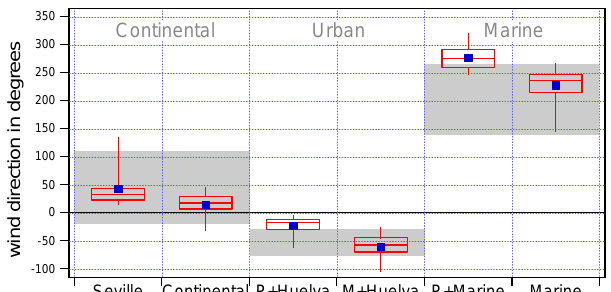
Fig. 3. Comparison of wind directions associated with the classified air mass categories (HYSPLIT) with wind direction ranges used for the identification of the three sectors. The wind directions associ- ated with the HYSPLIT air mass categories are presented as box plots (blue marker: mean, box: 25–75% percentiles with median, whiskers: 5% and 95% percentiles) while the wind direction ranges are shown as grey shaded